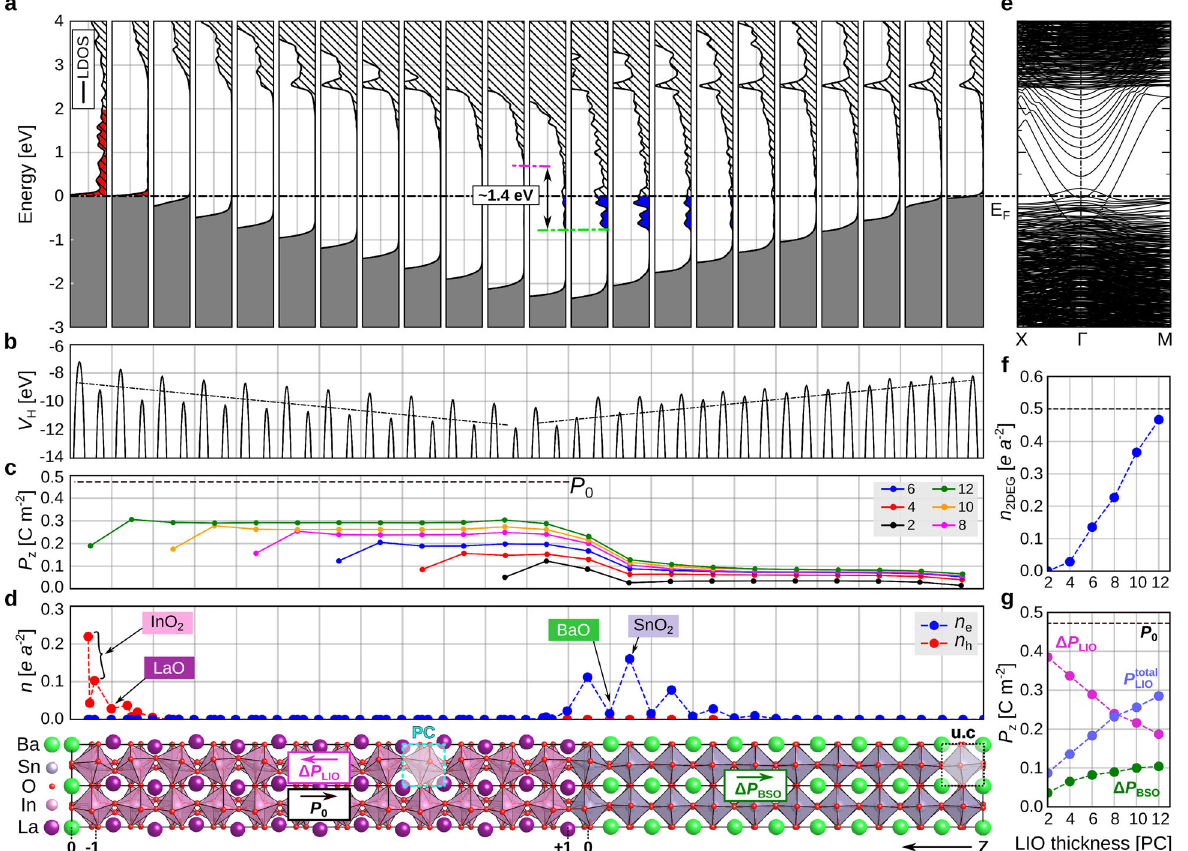
Fig. 1 Stoichiometric periodic heterostructure. The system is formed by LIO 12 /BSO 10 in out-of-plane direction z (bottom), which is shared between panels (a – d) as their horizontal axis. P 0 is the formal polarization oriented from the (InO 2 ) − 1 to the (LaO) + 1 plane. a Local density of states per unit cell (LDOS) where the Fermi level is set to zero (also in panel ( e )). The shaded gray area indicates the occupied valence band. The partially unoccupied valence (hole) and the occupied conduction (electron) states, resulting from electronic reconstruction, are highlighted by red and blue color, respectively. The dashed green and pink lines indicate the alignment of the conduction-band edges of BaSnO 3 and LaInO 3 at the interface. b In-plane averaged electrostatic potential along the z direction. The dashed lines are guides to the eye, highlighting the trend of the potential. c Total polarization per unit cell computed for different LaInO 3 thicknesses (in units of the pseudocubic unit cell, PC). d Distribution of the electron (hole) charge densities obtained by integrating over the occupied conduction (unoccupied valence) states shown with blue (red) colored area in panel ( a ). e Electronic band structure along X- Γ -M. f Density of the 2DEG in electrons per , violet) within the LaInO 3 block and changes of polar distortions within the LaInO 3 BaSnO 3 surface unit cell ( e per a 2 ). g Total polarization ( P LIO total ( Δ P LIO , magenta) and BaSnO 3 ( Δ P BSO , green) side as a function of the LaInO 3 thickness. The respective orientations are shown in the structural